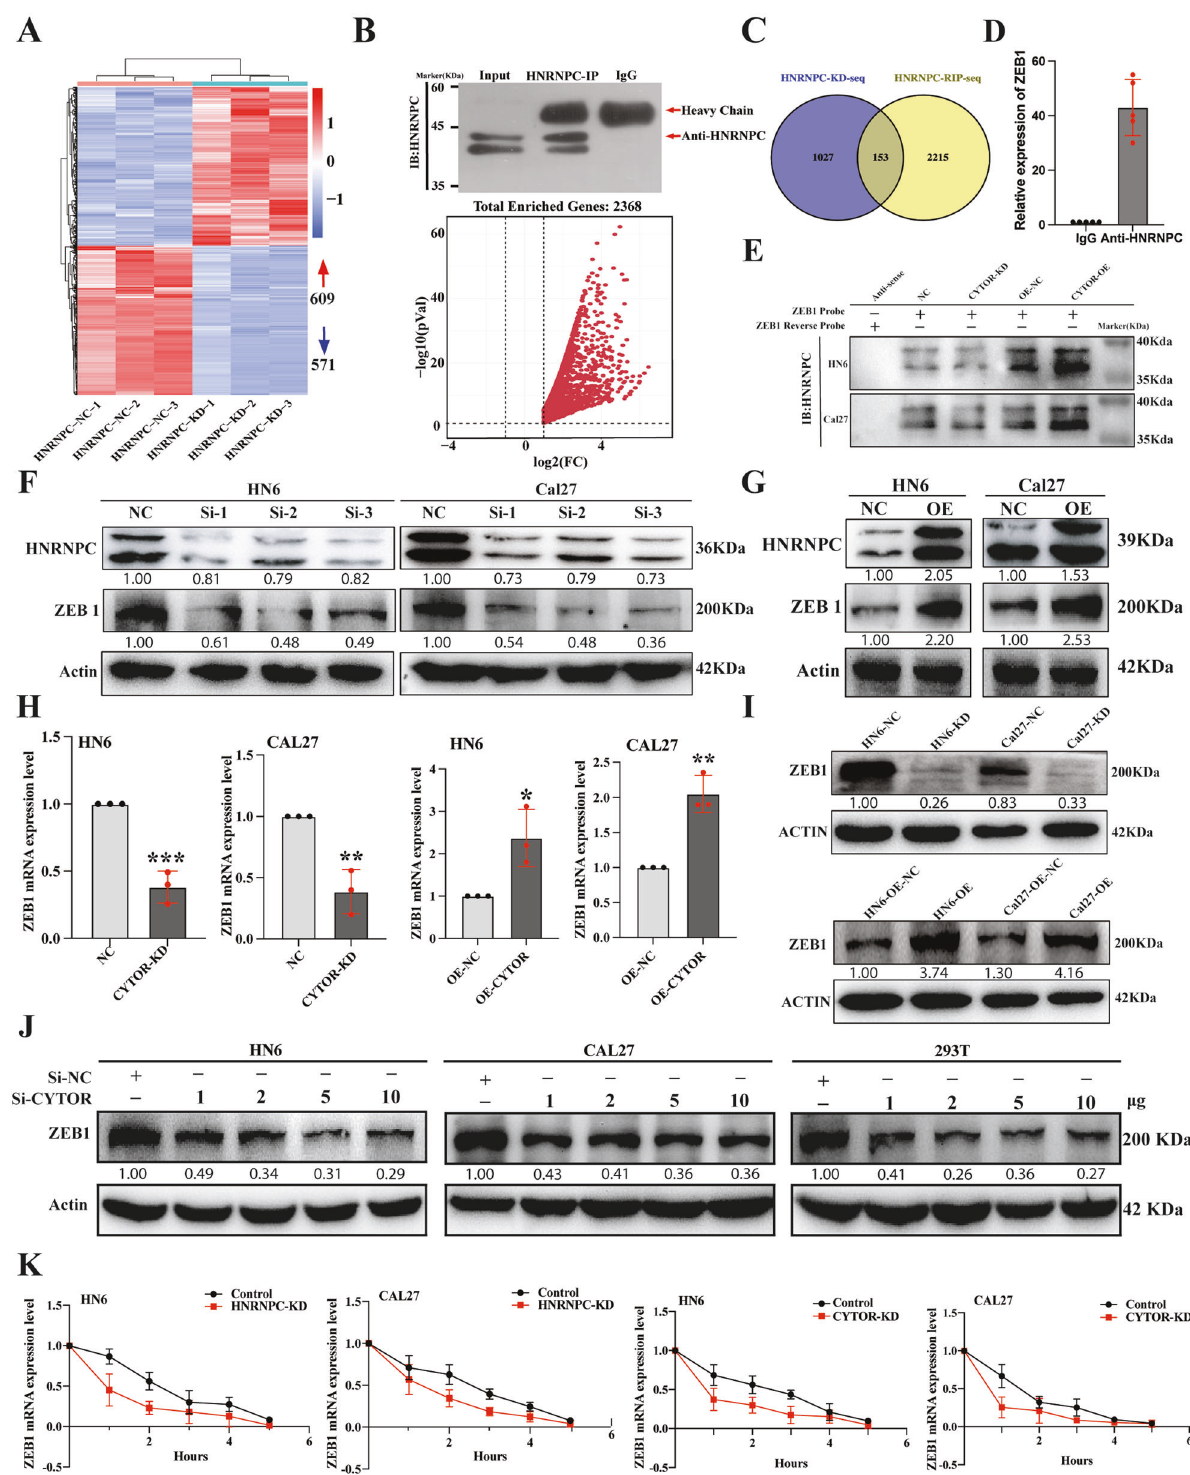
In light of these fi ndings, we then explored the Enhanced Permeability and Retention (EPR) effects of nanoparticle accu- mulation at tumor sites [37, 38] by synthesizing nanoscale metal- organic frameworks (NMOFs) to package siRNAs targeting CYTOR for suppression in an in vivo OSCC mouse model (Supplementary Fig. S12). We then assessed whether these tumor-targeting NMOFs could inhibit metastasis of oral cancer cells in a nude Cell Death and Disease (2022)